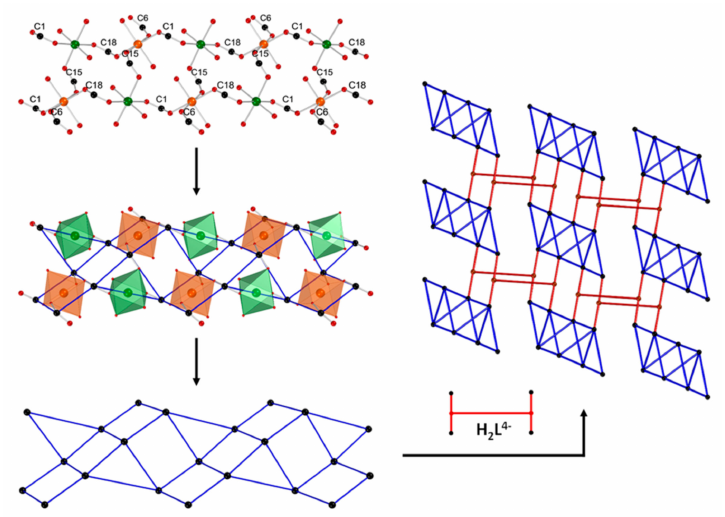
Figure 2. The deconstruction of the 3D framework of the 3D-Fe-MOF . Color code: Fe1 green, Fe2 orange, C black, O red, H 2 L 4 − dark red